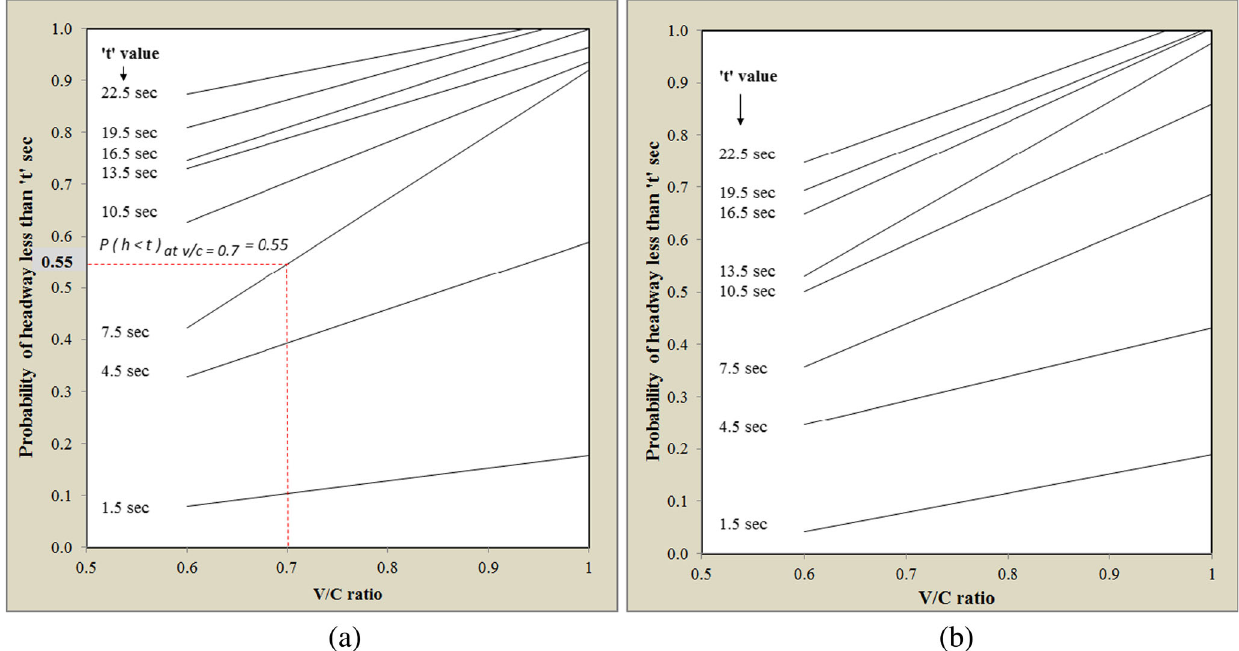
Fig. 5 Probability distribution nomograph developed based on the selected models: a west bound traffic and b East bound